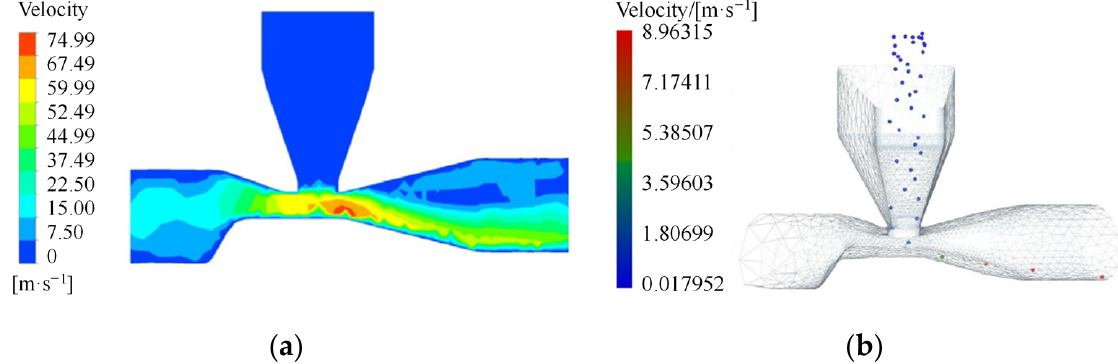
Figure 9. The coupling simulation of the metering process of a metering device for wheat and rapeseed [72] ( a ) CFD–DEM coupling simulation of airflow; ( b ) CFD–DEM coupling simulation of seed flow.